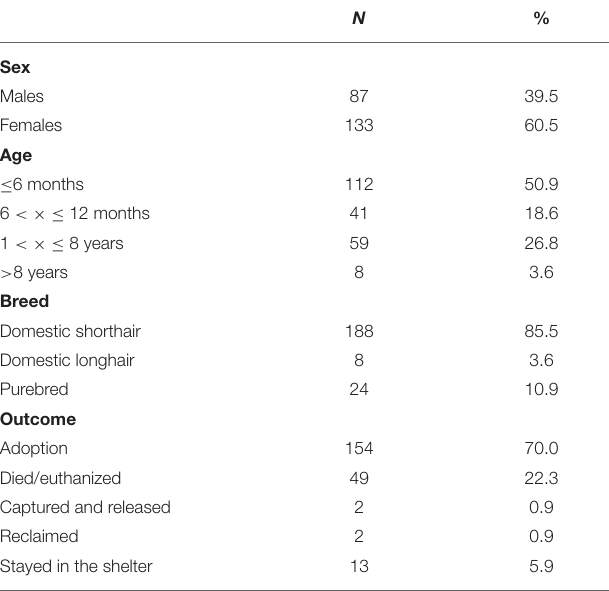
TABLE 3 | Characteristics of cats assessed in the shelter (sex, age, and